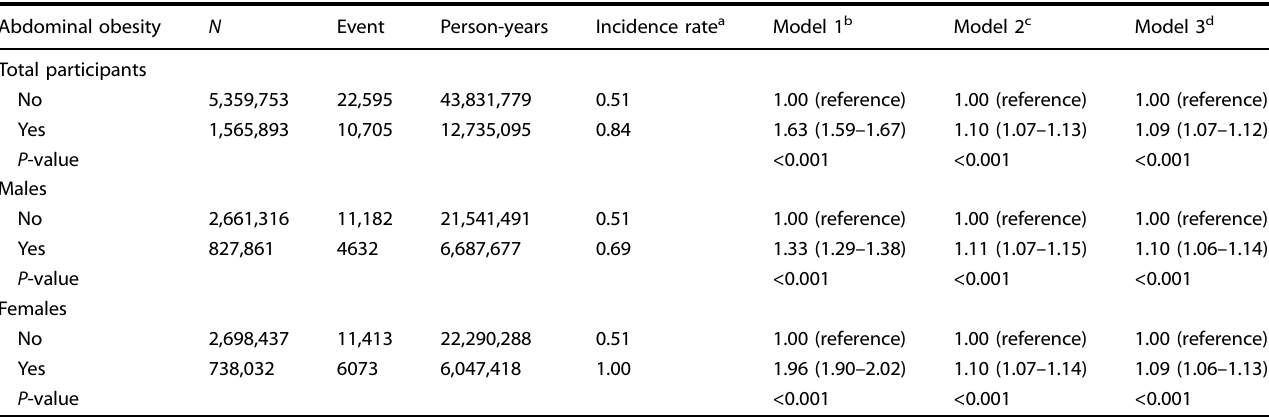
Table 3. Longitudinal associations between abdominal obesity and incident Parkinson ’ s